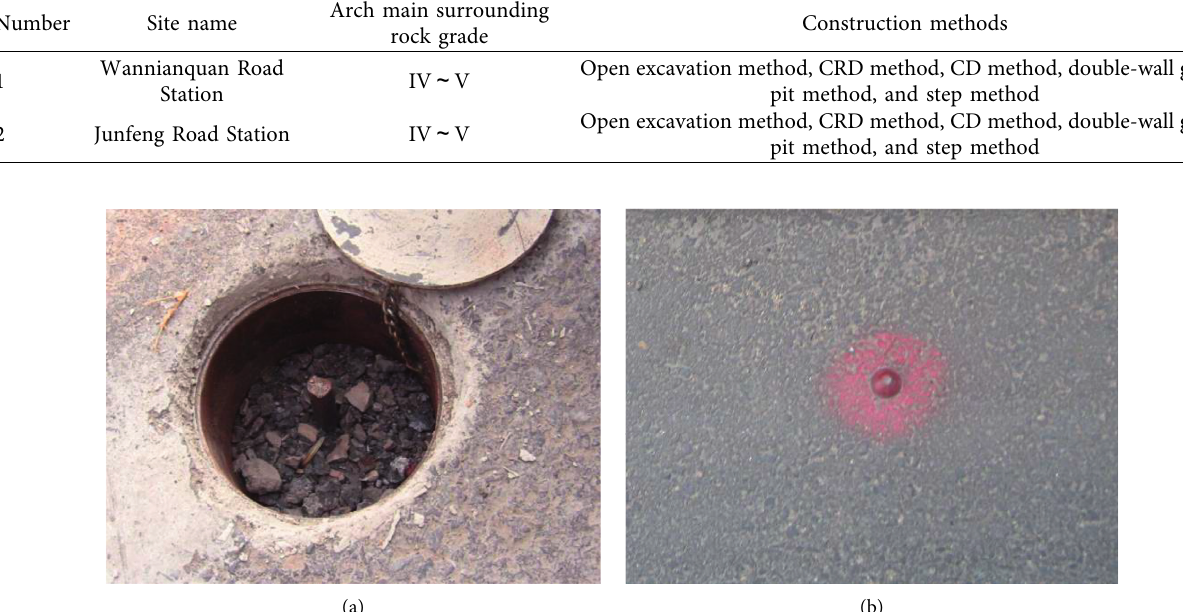
Figure 3: Surface settlement monitoring points. (a) Spike. (b) Monitoring stations.